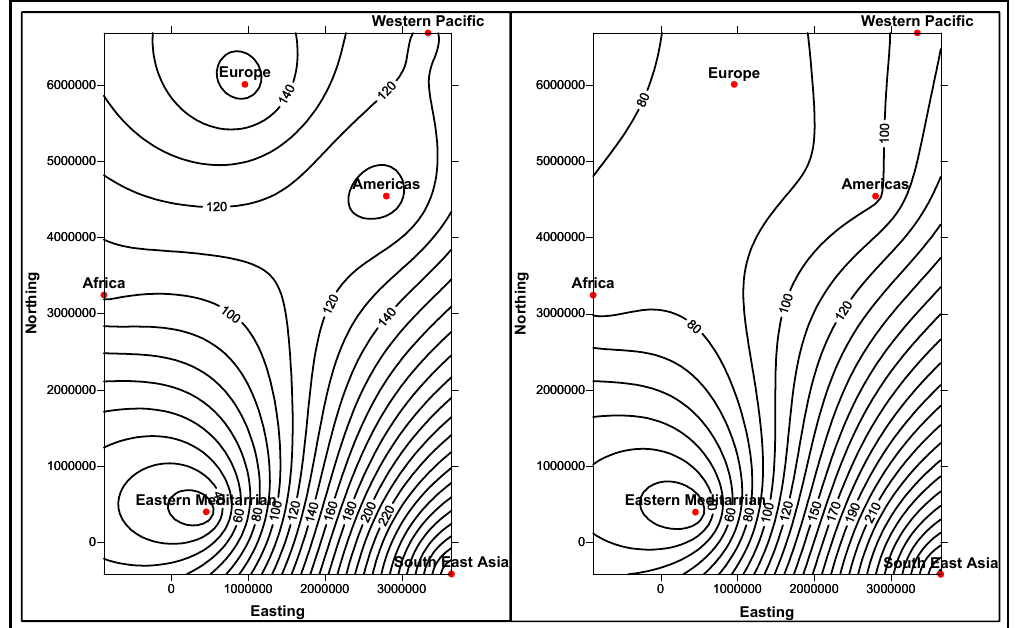
Figure 15. Map views for different regions showing diabetes deaths (34–65 age group of male and female, in